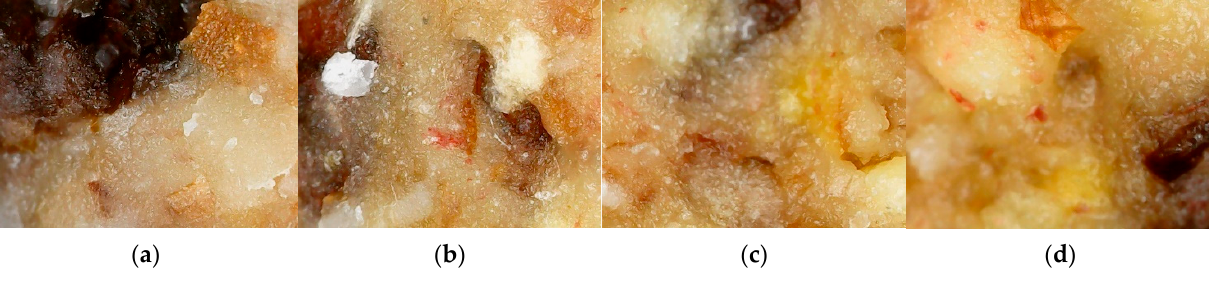
Figure 2. Electronic microscopic photographs of bonbon formulations’ surface (160×): ( a ) control sample; ( b ) LPP10; ( c ) LPP20; ( d ) LPP30.